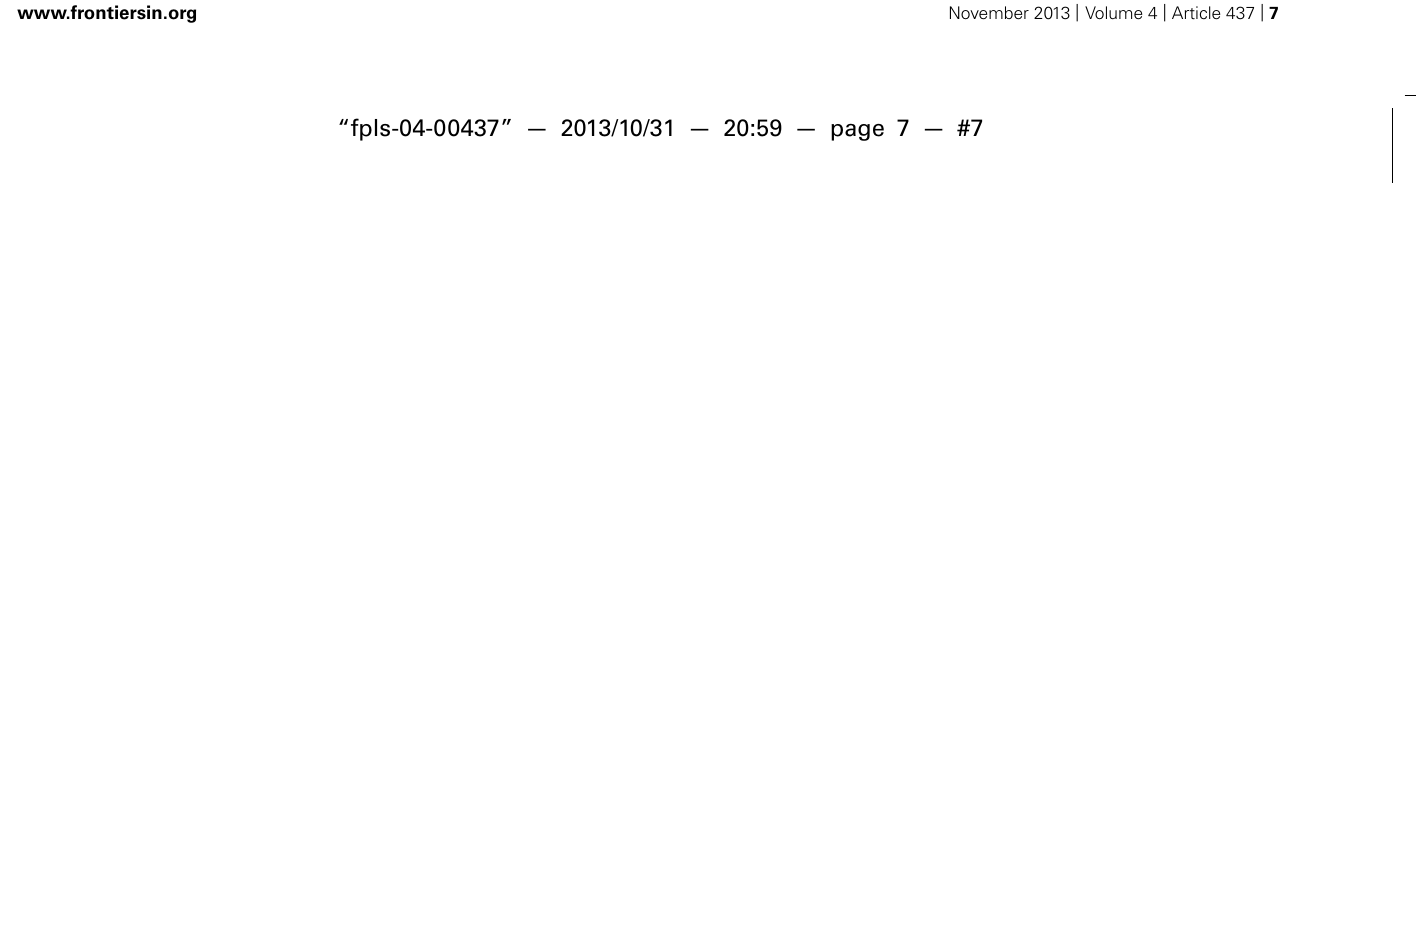
was carried out for 50 × 50 combinations of Transpiration_th and LER_th. Stars refer to the parameter values maximizing plant biomass for both water deficit conditions. The pie charts close to each 3D graph represent the proportion of the variance explained by both parameters and their